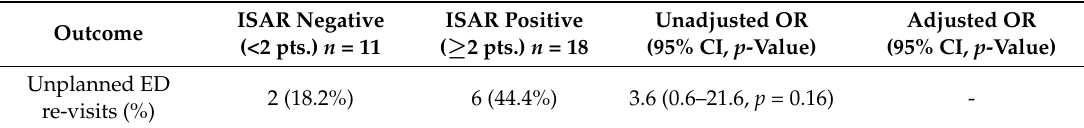
Table 3. Outcome analysis in patients if a single geriatric consultation was performed during the ED stay.